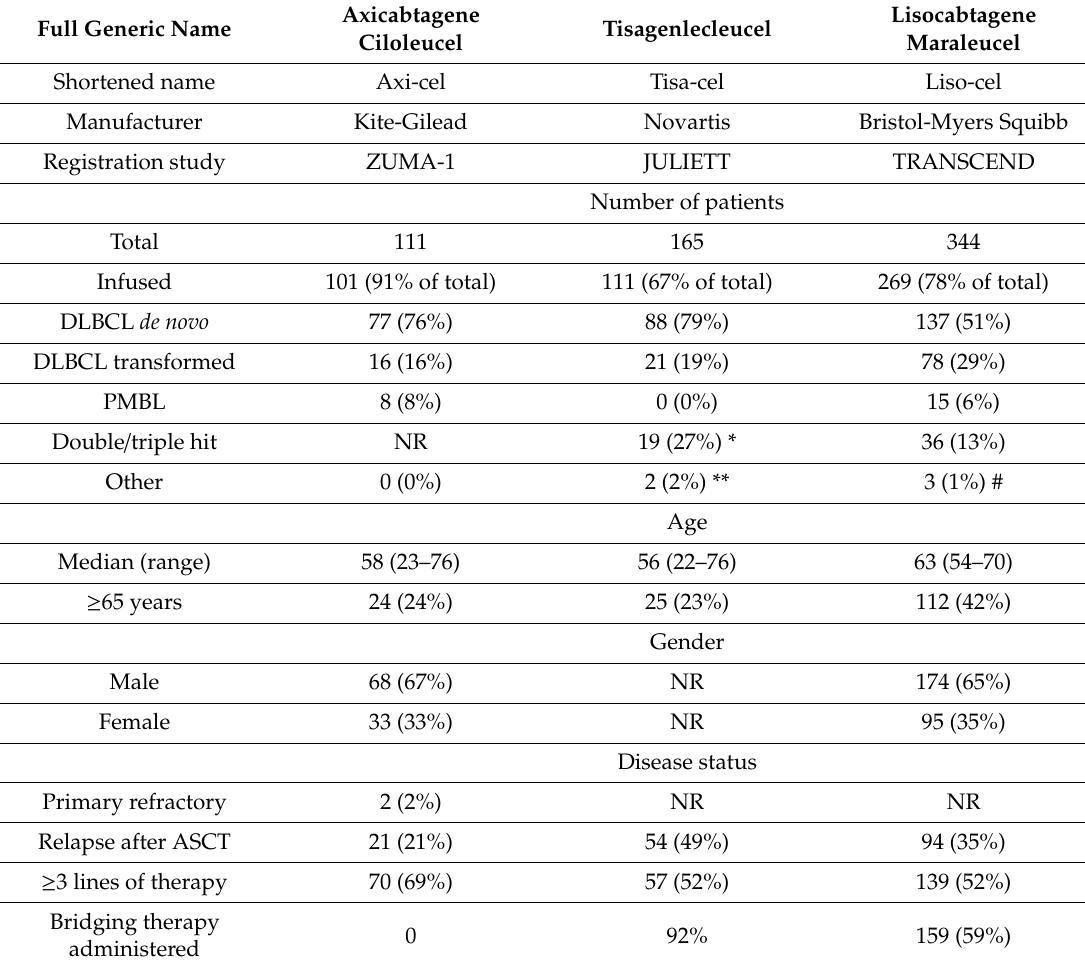
Table 7. Characterization of clinically approved CAR T-cell